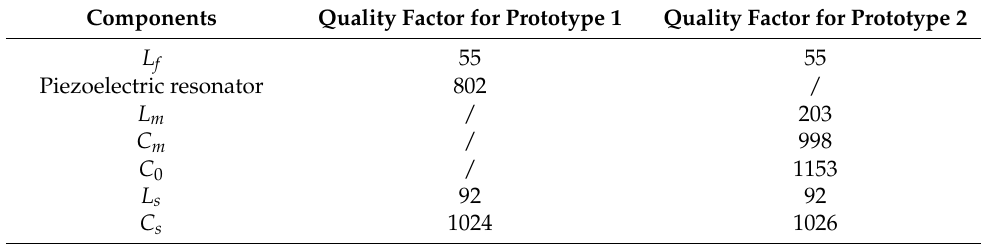
Table 5. Components quality factor of both